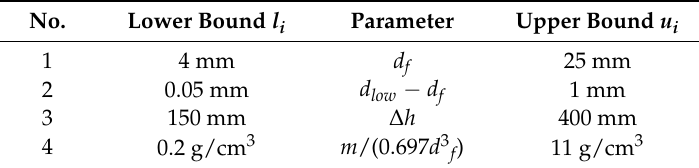
Table 2. List of constraint functions for optimization